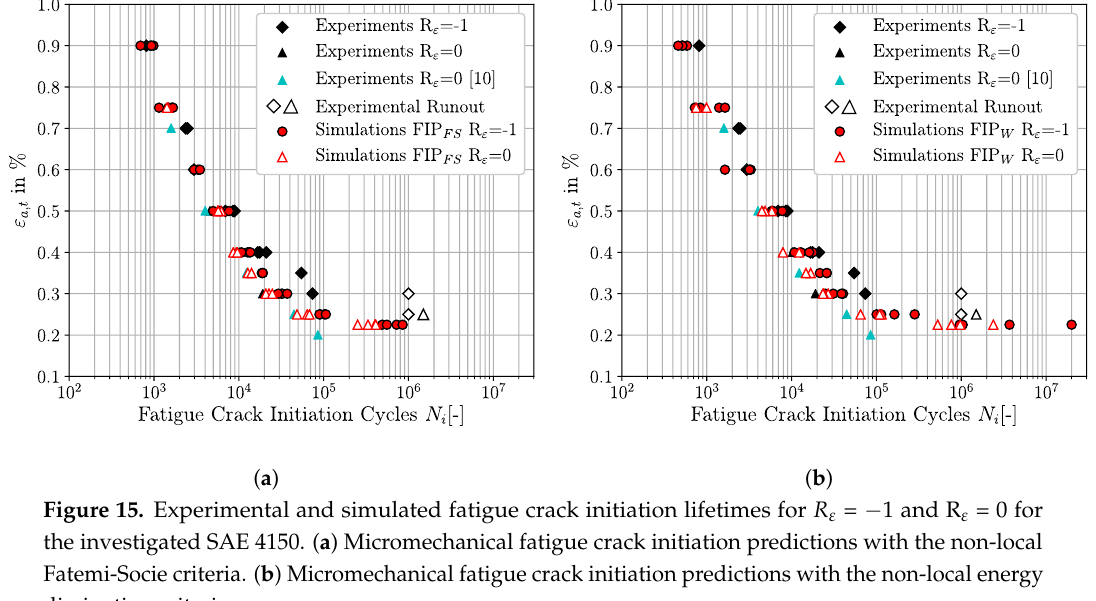
1 and R ε = 0 for −